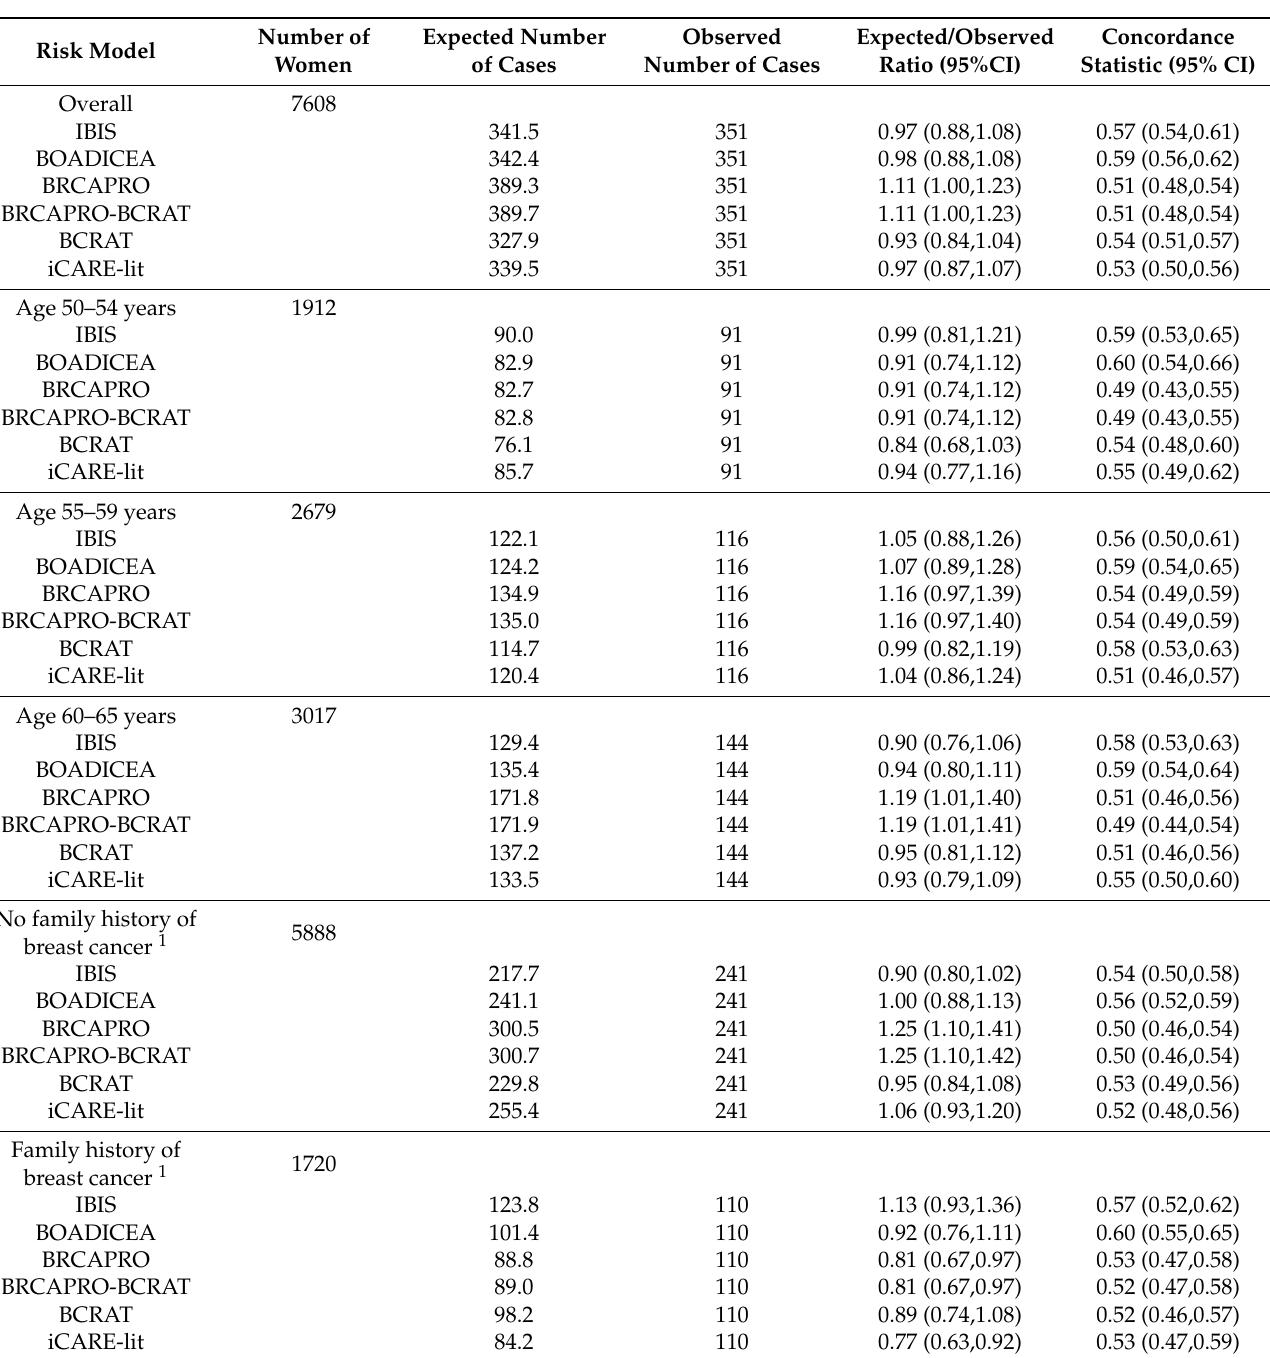
Table 2. Calibration and discrimination of 15-year risks for six breast cancer risk